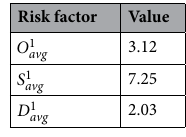
Table 7. The average value of 3 risk factors.